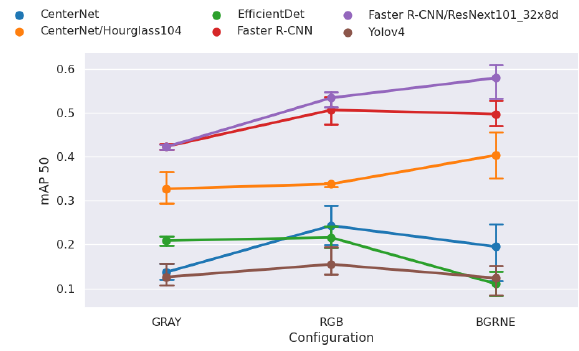
Figure 9. Multispectral: the performance of the object detectors on multispectral data. (’BGRNE’— multispectral recordings, ’RGB’—color images,